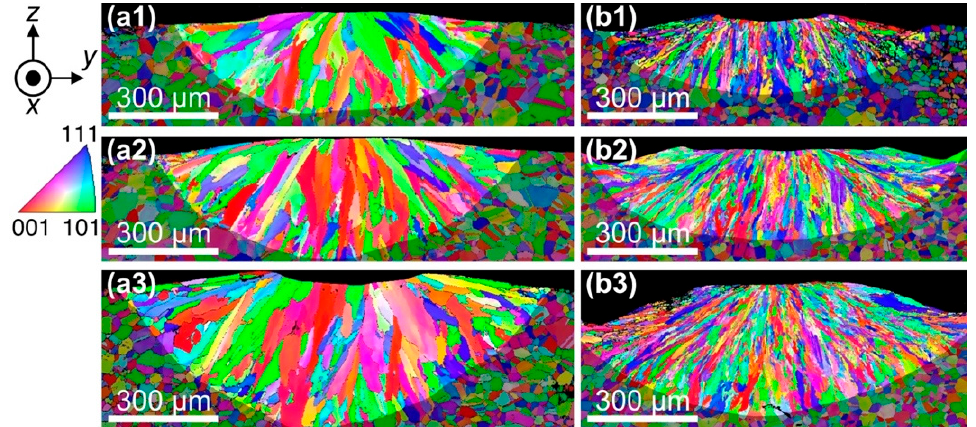
Figure 4. SEM electron backscatter diffraction (EBSD) IPF orientation maps on the transversal cross section of ( a1 – a3 ) 316L and ( b1 – b3 ) 304 SS samples irradiated with electron beams under V = 100 mm/s and various beam power conditions: ( a1 , b1 ) P = 600 W, ( a2 , b2 ) P = 900 W, and ( a3 , b3 ) P = 1200 W.